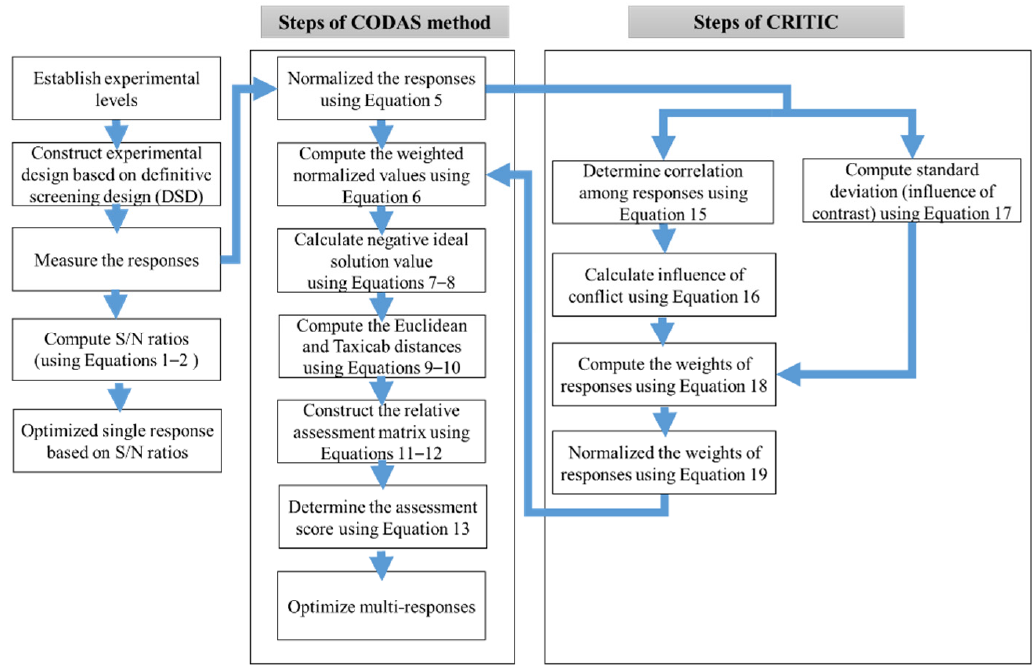
Figure 3. Methodology for single ‐ and multi ‐ response optimization.